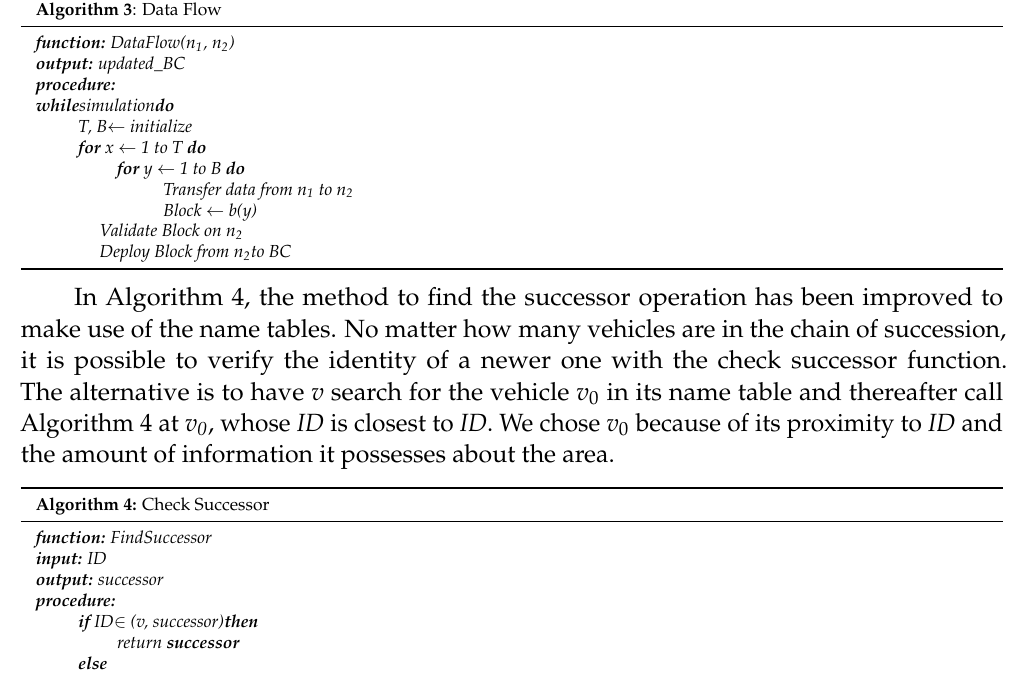
Algorithm 3 : Data